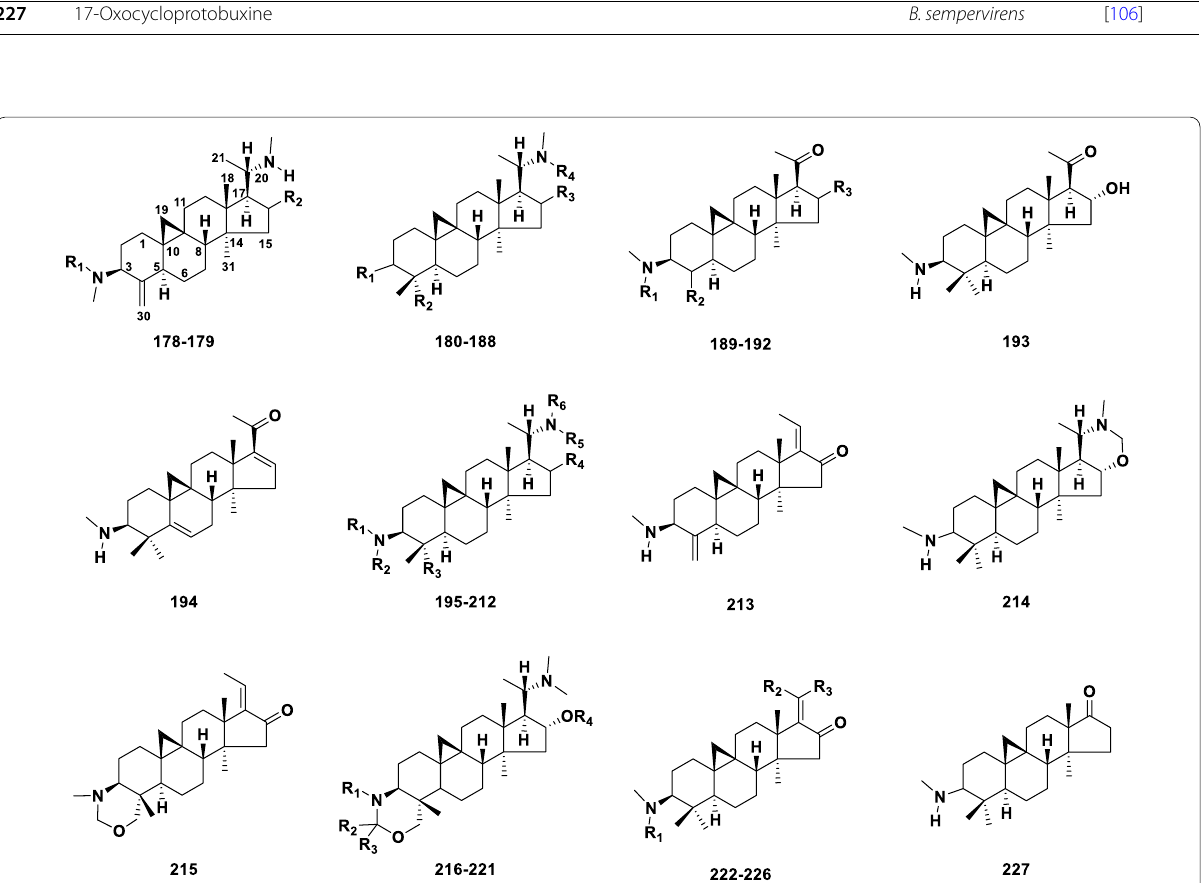
Fig. 5 Structures of 9 β ,19‑cyclo‑14 α ‑methylpregnane type steroidal alkaloids